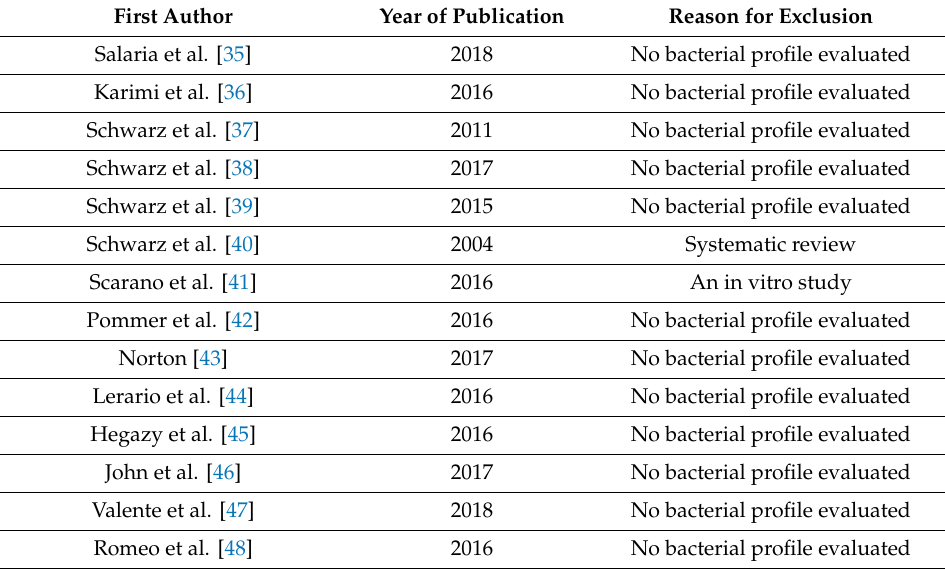
Table 3. Reasons for exclusion of